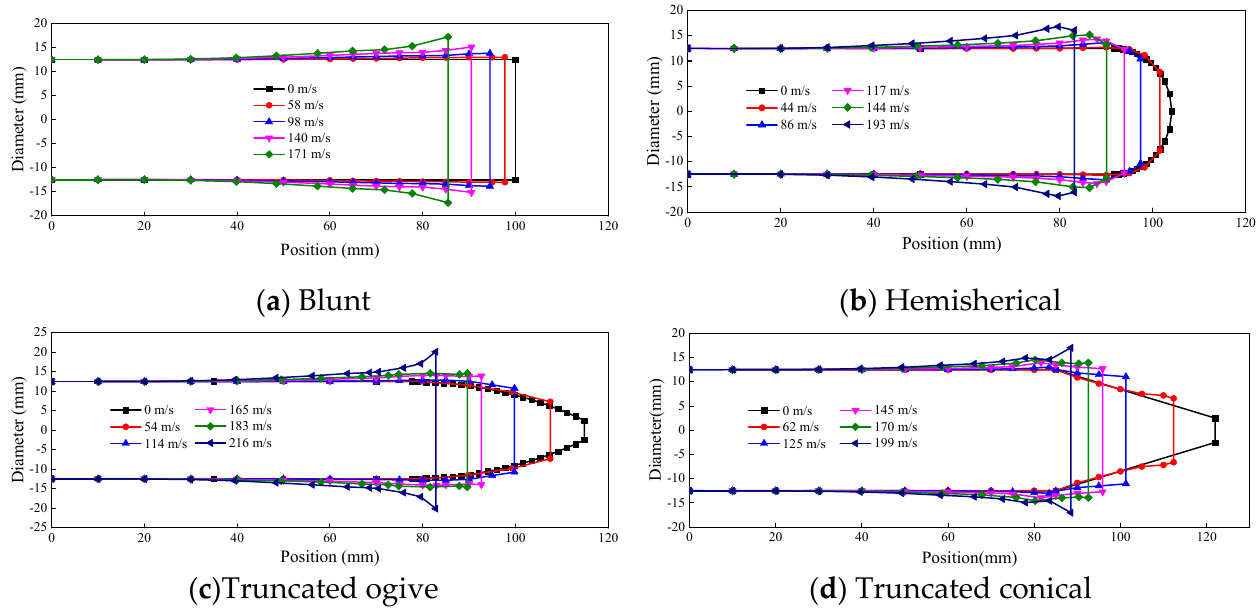
Figure 12. Comparison of initial dimensions and final deformation of the four types of projectiles.